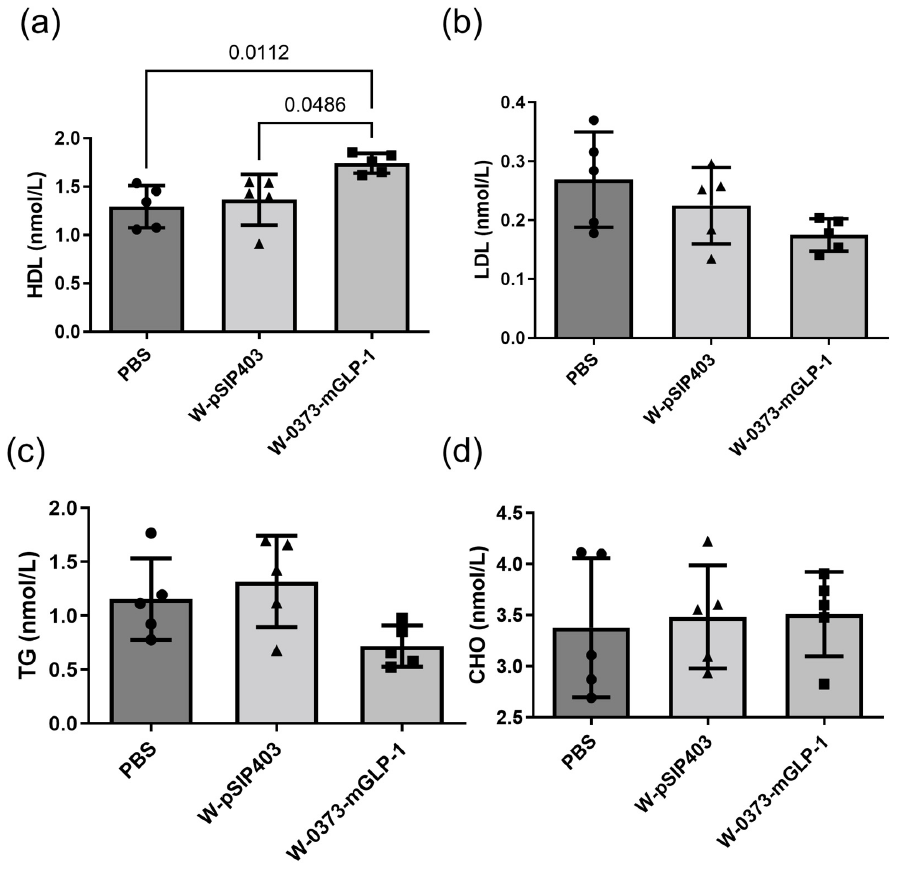
Figure 7. Effects of 14-day W-0373-mGLP-1 administration on plasma ( a ) high-density lipoprotein (HDL), ( b ) low-density lipoprotein (LDL), ( c ) triglyceride (TG), and ( d ) cholesterol (CHO) concentrations in db/db mice. All data are represented as mean ± SD.